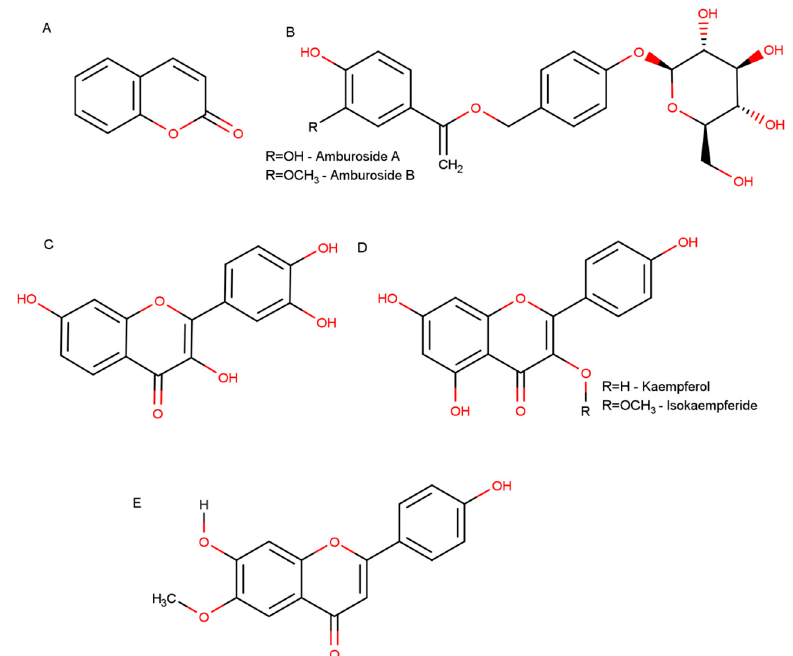
Figure 1. Representative chemical structures of A. cearensis bioactive compounds. ( A ) Coumarin (1,2-benzopyrone); ( B ) phenol glucosides amburoside A and amburoside B; ( C ) fisetin; ( D ) flavonoids kaempferol and isokaempferide; ( E ) flavonoid afrormosin.